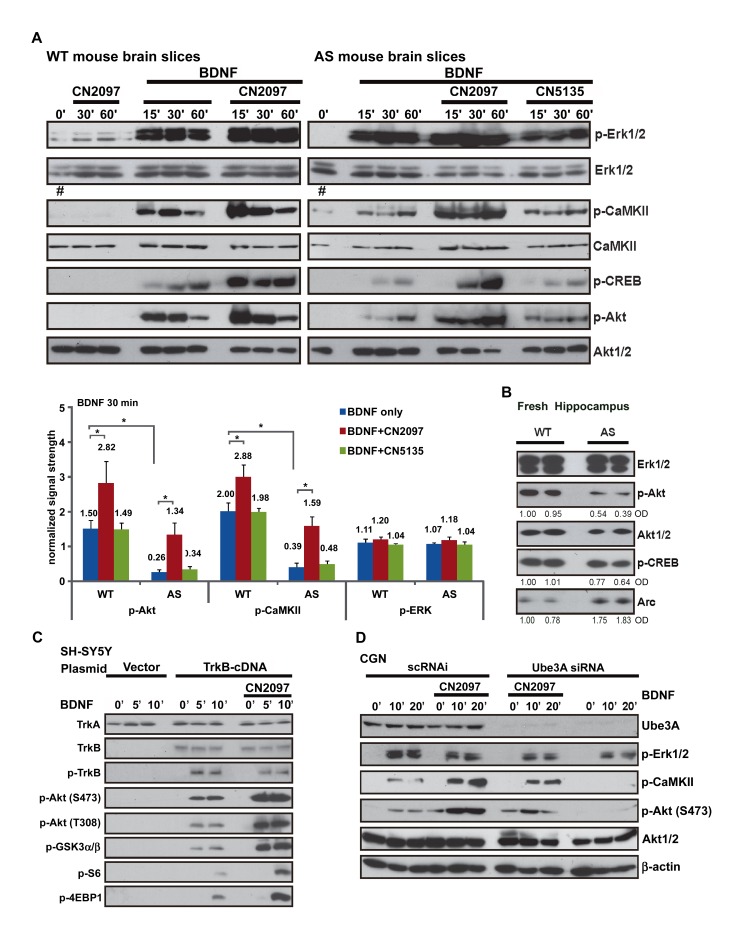
Defective BDNF signaling in AS mice and rescue with CN2097.(A) CN2097 enhances defective BDNF induced CaMKII/CREB and Akt phosphorylation in AS brain slices. Upper panel: Representative Western blots showing the relative abundance of phosphorylated protein (p-Erk1/2, p-CaMKII, p-CREB, and p-Akt-S473) from lysates prepared from WT and AS brain slices. Slices were stimulated with BDNF (50 ng/ml) in the presence or absence of CN2097 or the control compound CN5135 (2 µM; 30-min pretreatment). Slices were evaluated at designated times (‘, min) following BDNF treatment. The level of basal p-CamKIIα (phospho-Thr286) is enhanced in AS untreated slices compared to WT (0′, lanes indicated with a #). Total Erk1/2, Akt1/2, and CaMKII loading controls are shown. Lower panel: Quantitative analyses of p-Akt, p-CaMKII, and p-Erk after 30 min BDNF treatment, normalized to individual loading controls. Statistical significance was calculated using a two-tailed Student's t test. Data are mean ± SEM from at least three independent experiments. *p<0.05. (B) Freshly dissected AS mouse hippocampus show lower endogenous p-Akt and p-CREB expression and more Arc expression versus WT mouse. Representative Western blots showing the relative abundance of phosphorylated protein (p-CREB and p-Akt-S473) in lysates. Erk1/2, Akt1/2, and Arc are shown. Optical densities normalized to WT (left lane) are indicated below selected rows. (C) CN2097 enhances BDNF-induced PI3K/Akt/mTORC1, but not Erk signaling in SH-SY5Y cells. SH-SY5Y cells transfected with control empty vector (Vector) or TrkB cDNA (48 h) were treated with BDNF (25 ng/ml) in the presence or absence of CN2097 (2 µM, 20-min pretreatment) for the indicated time points. Phosphorylation of Akt, GSK, S6 (p70S6K), 4E-BP1, and TrkB were detected using indicated antibodies. Total, TrkA, and TrkB are shown to confirm equal sample loading and equivalent levels of TrkB-cDNA expression respectively. (D) Western blot analysis showing knockdown of Ube3A in WT CGNs inhibits BDNF signaling. CGNs (CGN; age p5) transfected with scrambled control (scRNAi, 200 nM, 24 h) or Ube3A siRNA oligonucleotides (200 nM, 24 h) were serum starved and treated with BDNF (25 ng/ml) in the presence or absence of CN2097 (2 µM, 20-min pretreatment) for indicated time points. Western blots were probed for phosphorylation of Erk, CaMKIIβ and Akt; total CaMKII, Akt, and β-actin were detected as loading controls.